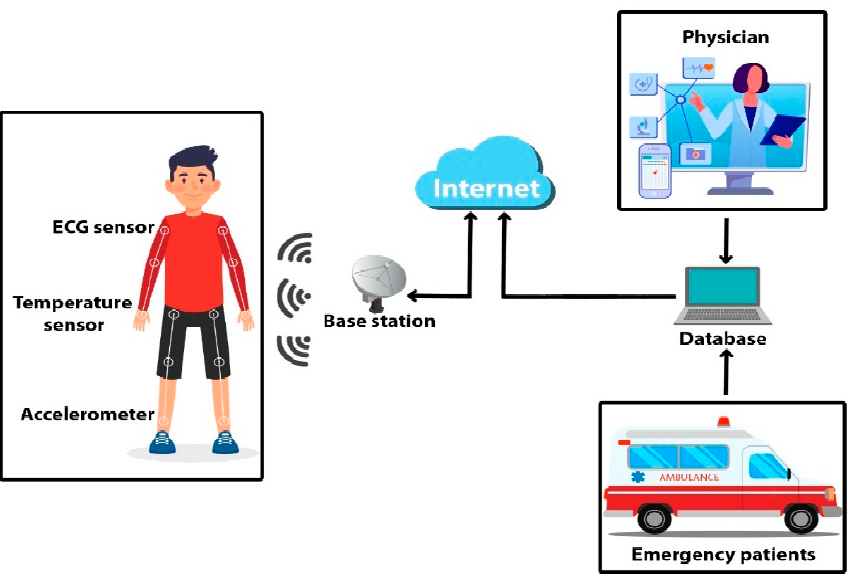
Figure 1. Architecture of IoT-based smart healthcare applications.